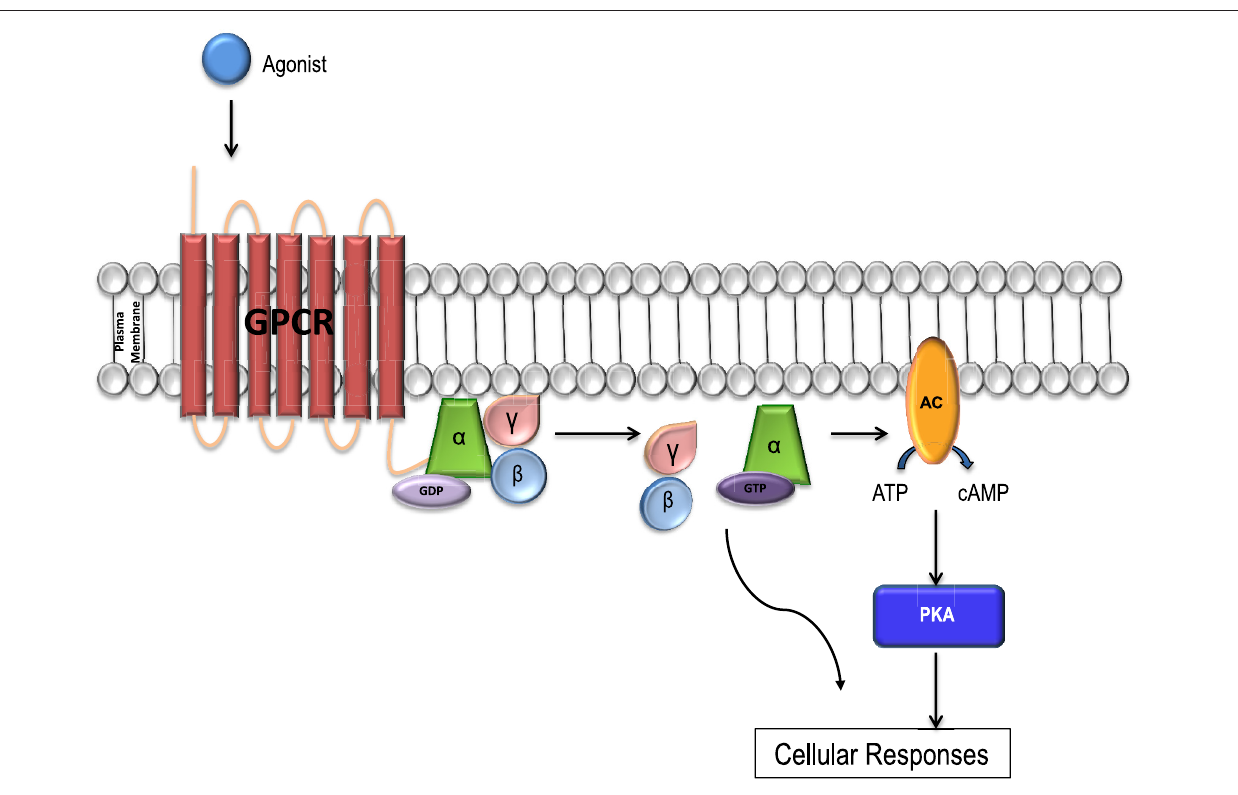
FIGURE 1 | GPCR signal transduction. Each GPCR forms a complex with a unique G α subunit. When the receptors are inactive the G α subunit is inactive, bound to GDP and in a heterotrimeric conformation with βγ -subunits. The α and γ subunits are attached to the plasma membrane by lipid anchors. Once bound to a ligand, the receptor is activated and undergoes a conformational change, and the G α subunit releases GDP, binds to GTP and is activated. The G α subunit then releases the βγ complex leading to the activation of a variety of downstream effector molecules by the G α subunit and βγ complex separately. The activated G α subunit can bind to and activate a number of enzymes including adenylyl cyclase (AC) which catalyzes ATP into cAMP. Increases in the concentration of cAMP lead to the activation of the PKA enzyme which in turn activates the downstream signaling pathways resulting in a variety of cellular responses including glucose regulation and inotropy. The cycle is completed when G α -GTPase hydrolyzes GTP to GDP and becomes inactive. The G protein complex then re-couples the G α with the G βγ